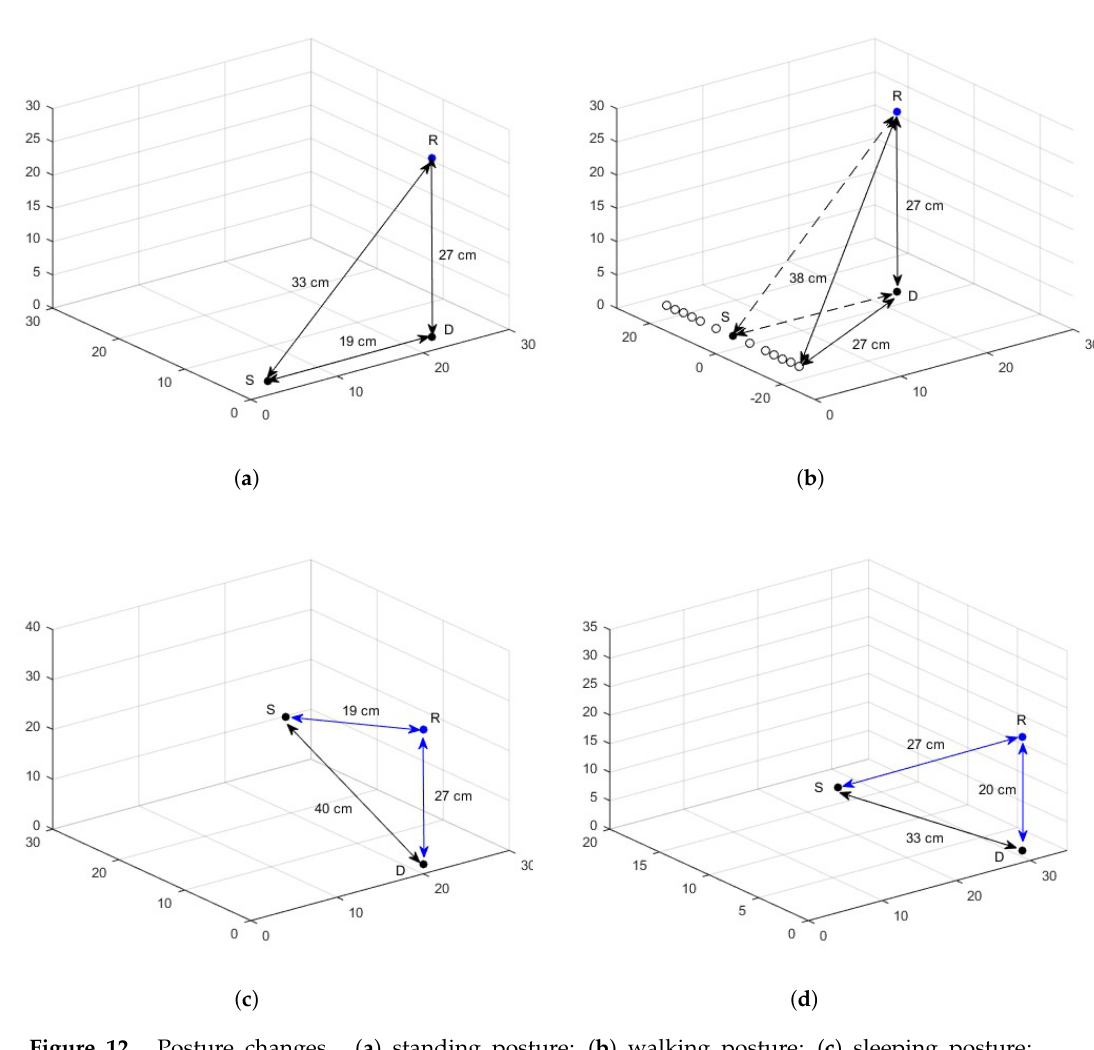
Figure 12. Posture changes. ( a ) standing posture; ( b ) walking posture; ( c ) sleeping posture; ( d ) cycling